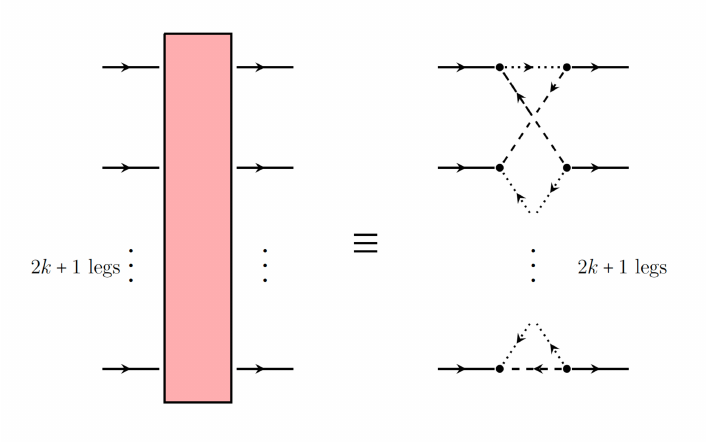
Figure 3 . The diagram which produces a planar contribution when inserted in the contraction of (2 k + 1) legs as an effective vertex. In the right hand side we use the same notation of [19, 22] for the matter hypermultiplets represented by the dashed and dotted lines. This contribution turns out to be proportional to ζ (4 k + 1) λ 2 k +1 , as a result of the integration over the loop momenta according to